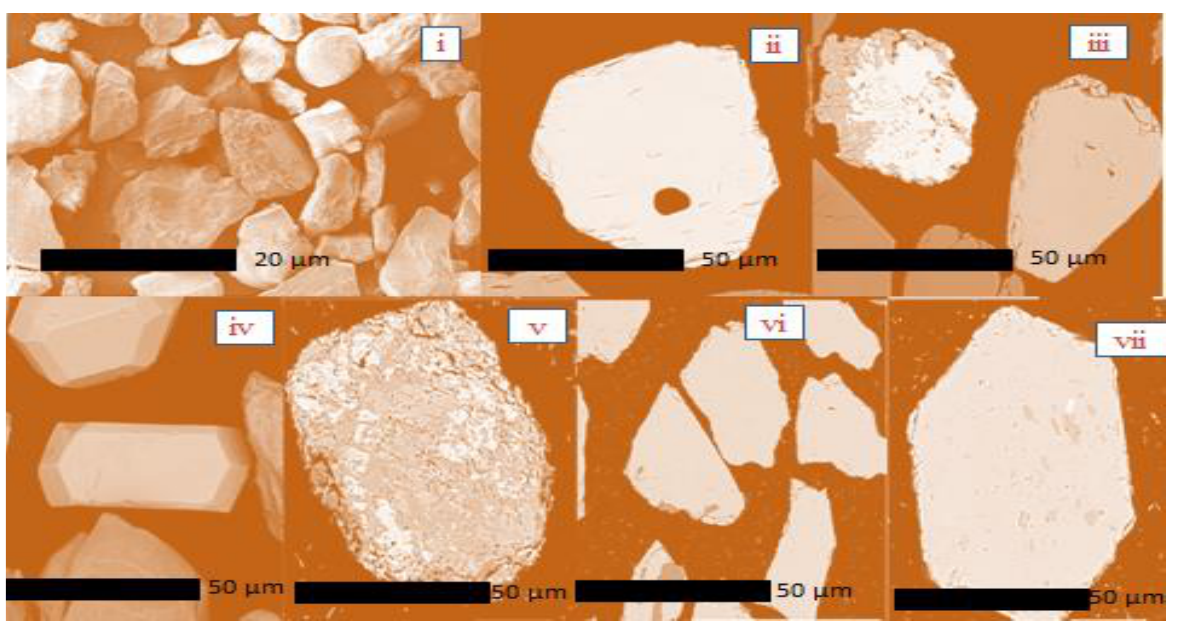
Figure 6. SEM images and elemental diagrams of several mineral grains in polished sections. ( i ) Dif- ferent ilmenite grains; ( ii ) monazite; ( iii ) titanite (Left top corner) and allanite (right); ( iv ) zircon; ( v ) a piece of mixed titanium rock that contains white ilmenite, light grey rutile, and dark grey titanite; ( vi ) quartz and ilmenite in garnet; ( vii ) zircon-containing garnet with the absence of Fe and Mn; Scale bar: ( i ) = 20 µ m, and ( ii ) to ( vii ) = 50 µ m.